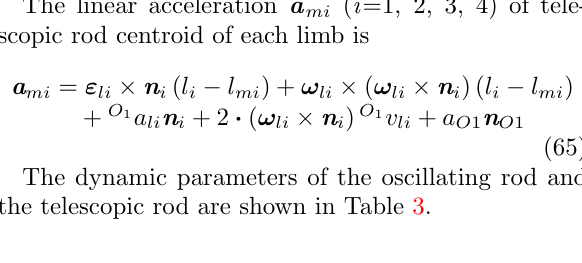
Table 3: The dynamic parameters of the oscillating rod and the telescopic rod ( i =1, 2, 3, 4) Parameters Description G fi The gravity vector of the os- cillating rod f , n fi The inertia force and inertia fi moment of the oscillating rod, respectively The gravity vector of the tele- scopic rod The inertia force and inertia moment of the telescopic rod, The gravity of the sliding plat- The inertia force and inertia